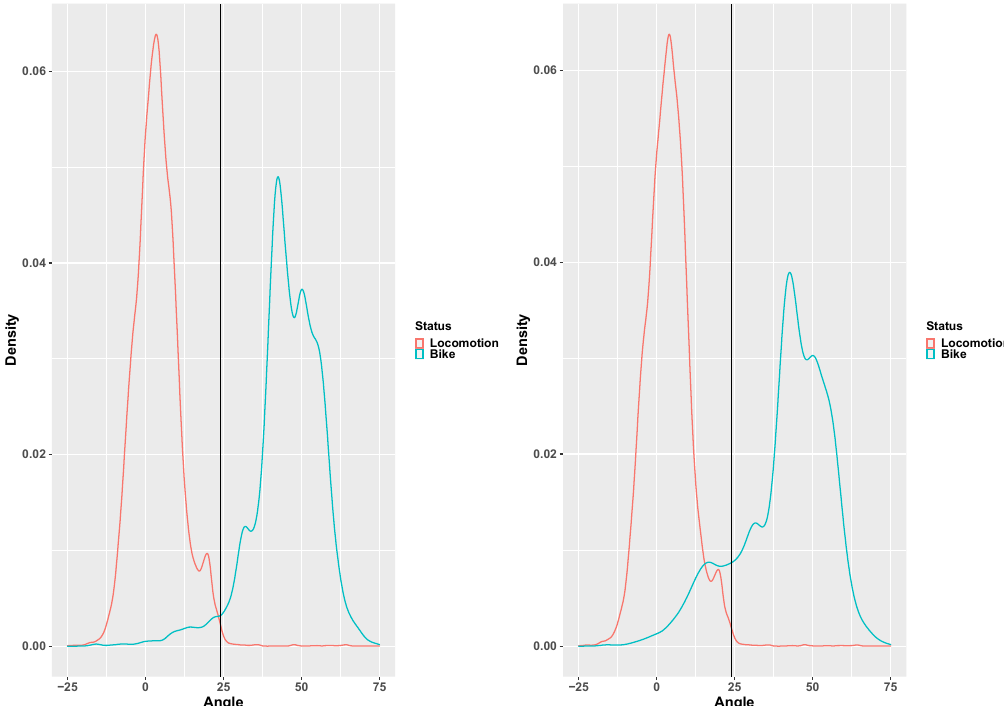
Figure 3. The pooled distribution of the angle signal feature for locomotion (red curve) and biking (green curve) only including the children and adolescents group in the left plot and all groups included in the right plot. The vertical line represents the original adult 24-degree threshold (Skotte et al. 2014).